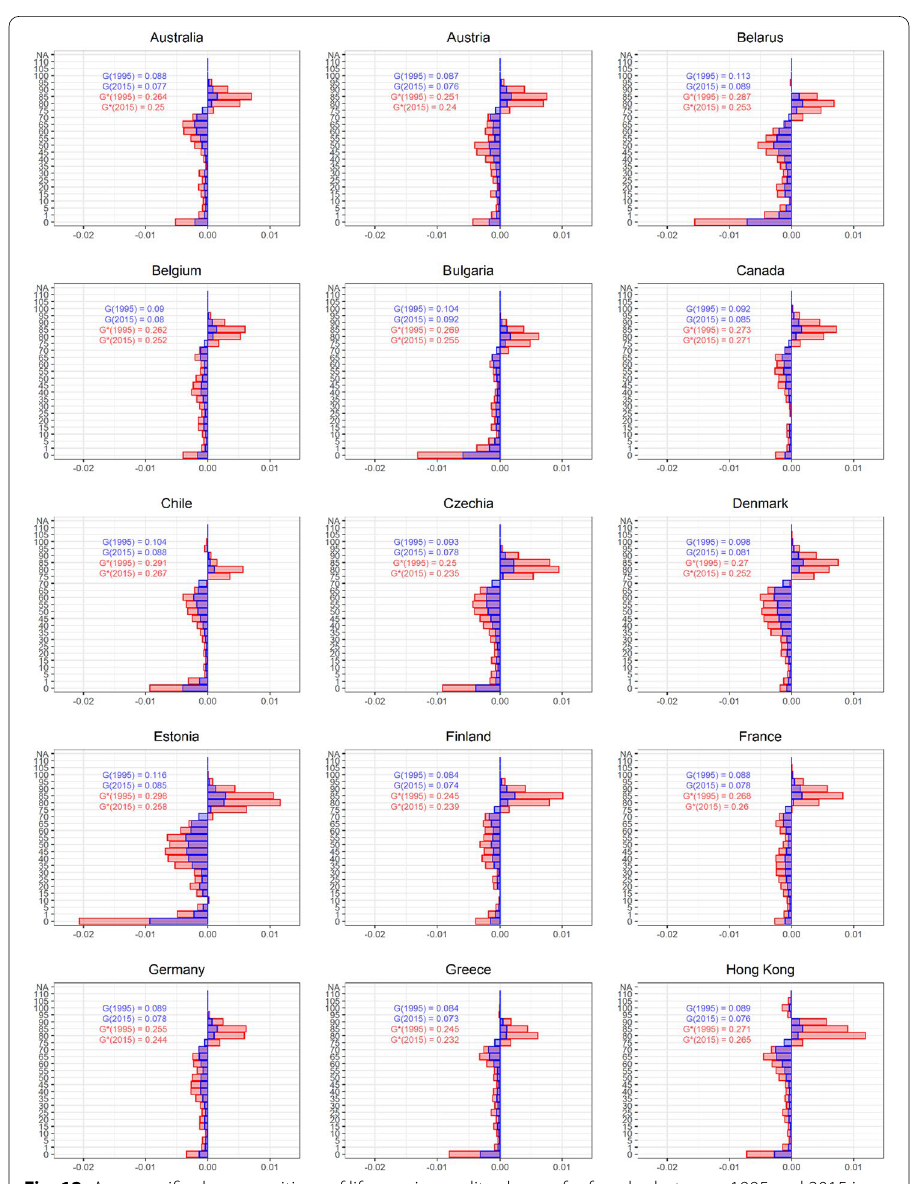
Fig. 12 Age-specific decompositions of lifespan inequality change for females between 1995 and 2015 in HMD countries. The blue bars show the age-specific contributions for the Gini index and the red ones for the normalized Gini index (Source: Authors’ elaboration based on the HMD